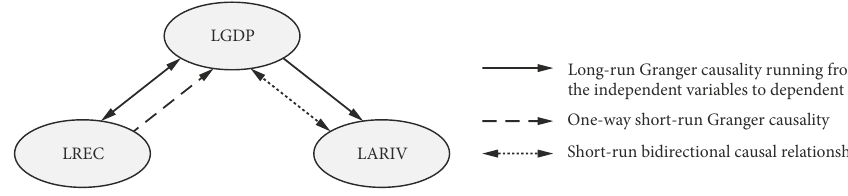
Figure 1. Granger causality relationship between GDP, ARIV and REC (source: authors’ contribution)